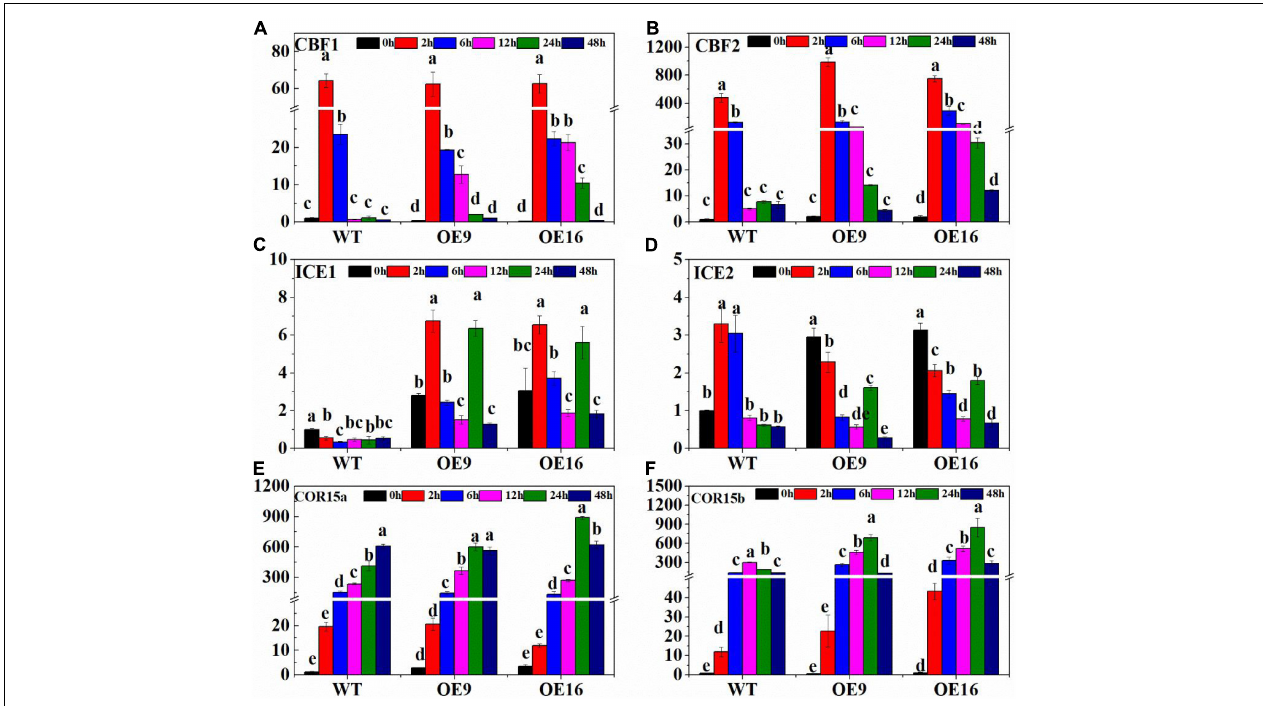
FIGURE 4 | The relative expression of cold stress-related genes including AtCBF1 (A) , AtCBF2 (B) , AtICE1 (C) , AtICE2 (D) , AtCOR15a (E) , and AtCOR15b (F) in wild-type (WT) and transgenic plants exposed to low temperature stress for 0, 2, 6, 12, and 24 h. OE: the CaALAD -overexpressing (OE) lines. The error bars represent the standard errors for three independent tests. Different letters indicate significant differences ( p < 0.05) based on Duncan’s test.